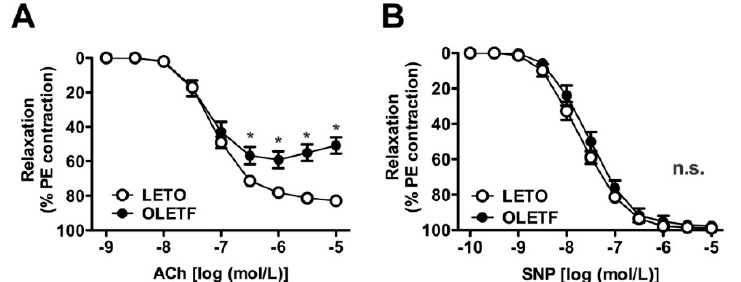
Figure 2. Concentration-response curves for acetylcholine (ACh) ( A ) or sodium nitroprusside (SNP) ( B ) in endothelium-intact aortas precontracted with phenylephrine (PE; 10 − 6 mol/L) isolated from LETO and OLETF rats. ( A , B ) The points show the means ± standard errors as percentages of the relaxation of the contraction induced by PE (10 − 6 mol/L). n = 5. * p < 0.05, LETO vs. OLETF. LETO, Long-Evans Tokushima